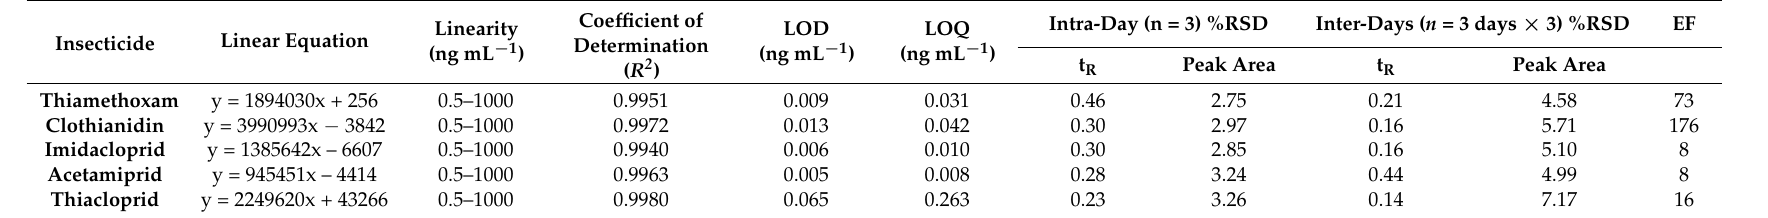
Table 1. Analytical performance of the proposed